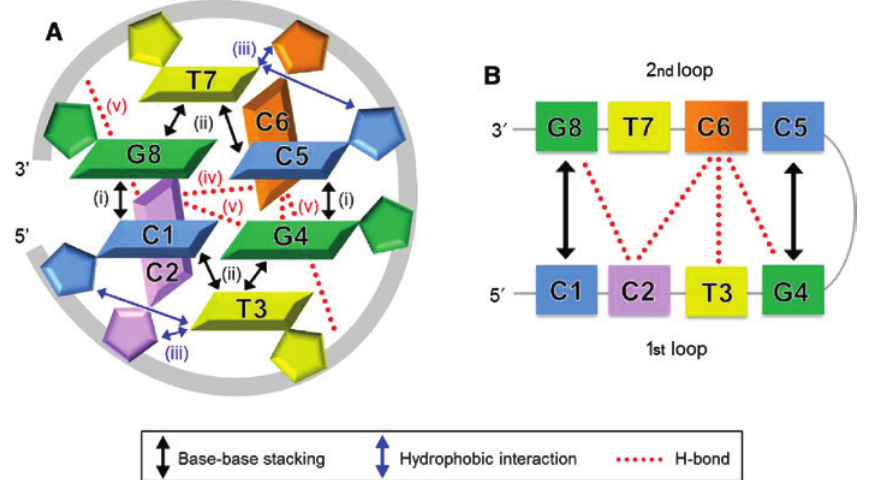
Figure 4: A schematic representation of the MDB structure formed by two CCTG repeats.